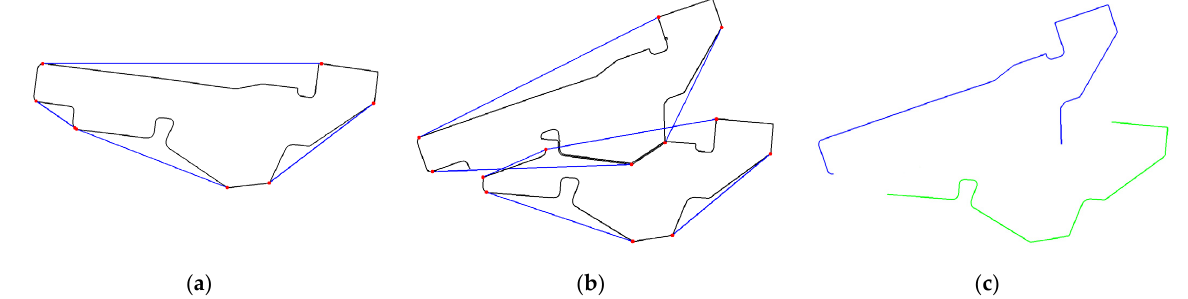
Figure 17. Segmentation and identification of the part contours: ( a ) segmentation of template part’s contour, ( b ) segmentation of stacked parts’ contours, and ( c ) separately identified two parts of the contour segments.